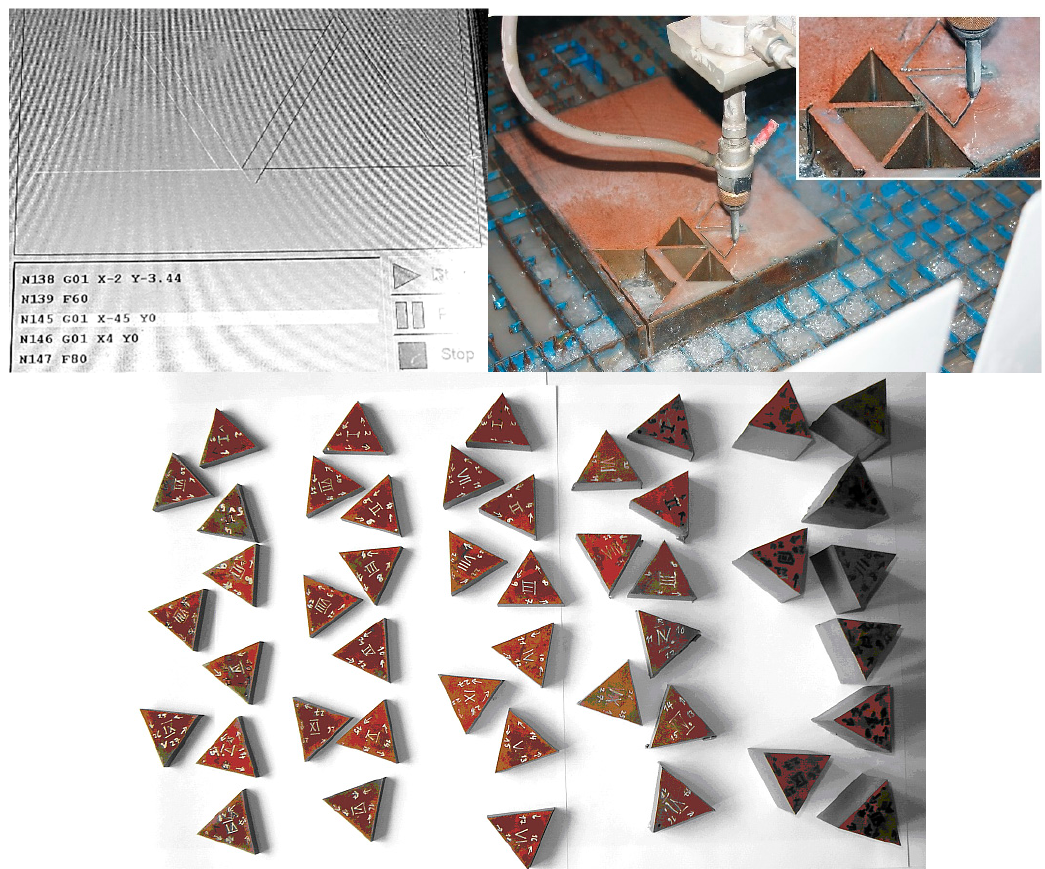
Figure 2. The cutting program’s screen and detail of the Hardox TM steel plates cutting (on the top); below samples prepared from (thicknesses from left to right 6, 6, 10, 15 and 40 mm).